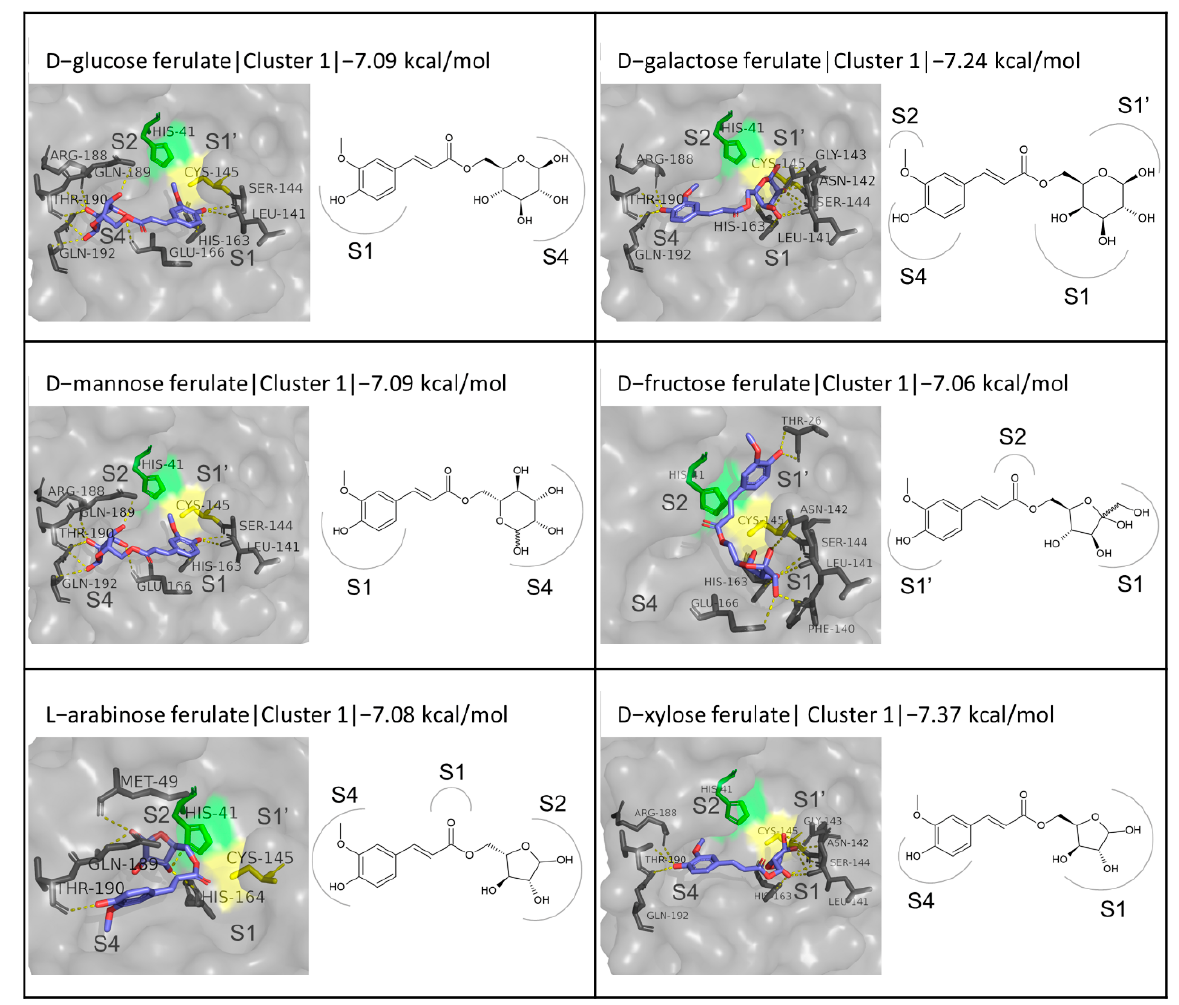
Figure 6. Structures and binding modes of the monosaccharide esters of FA at the active site of M pro